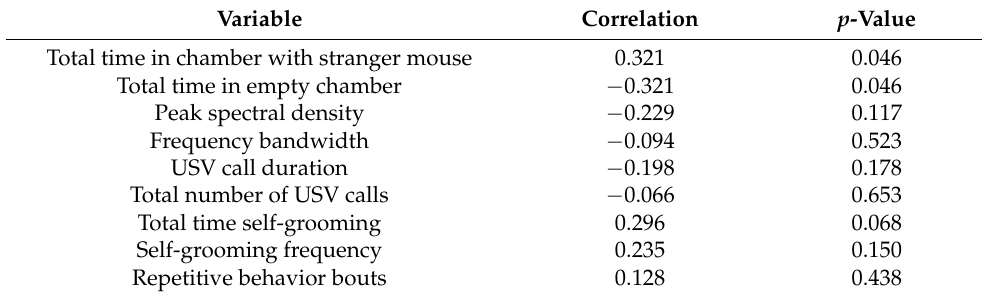
Table 1. Correlation between gut microbiota alpha diversity and behavioral